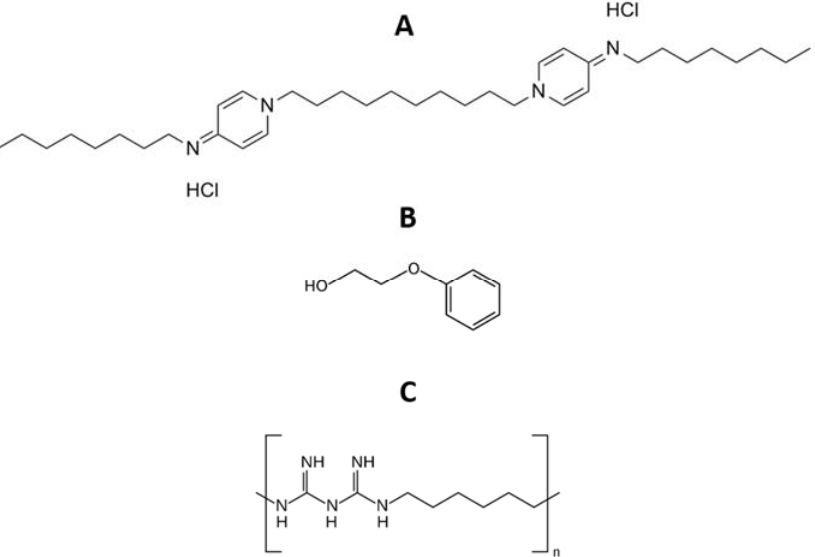
Figure 1. Chemical structure of ( A ) octenidine dihydrochloride, ( B ) 2-phenoxyethanol, and ( C )